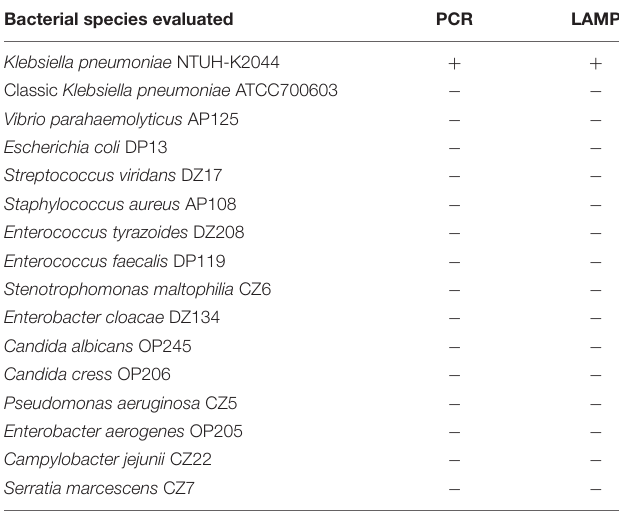
TABLE 1 | Different kinds of standard strains used to LAMP evaluation and the conditions of PCR reactions. Bacterial species evaluated